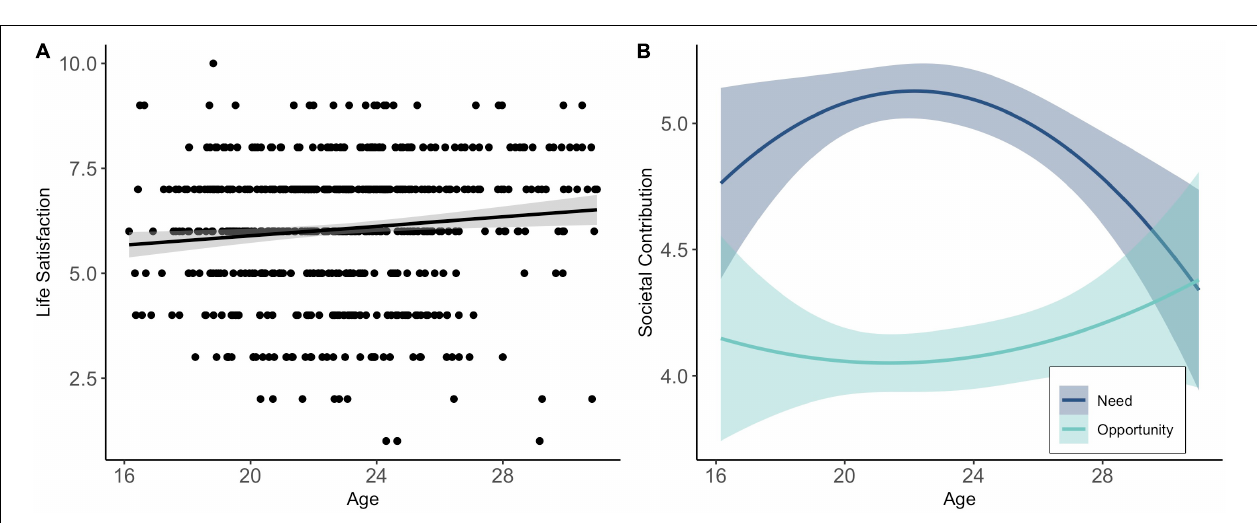
to contribute to society during COVID-19 peaked in late adolescence, around age